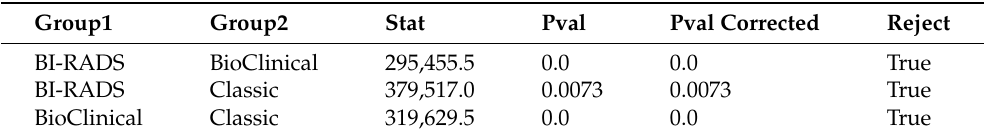
Table A8. Bonferonni-corrected Mann–Whitney U test results for section segmentation without auxiliary data in an ablation study with 10% of training data.